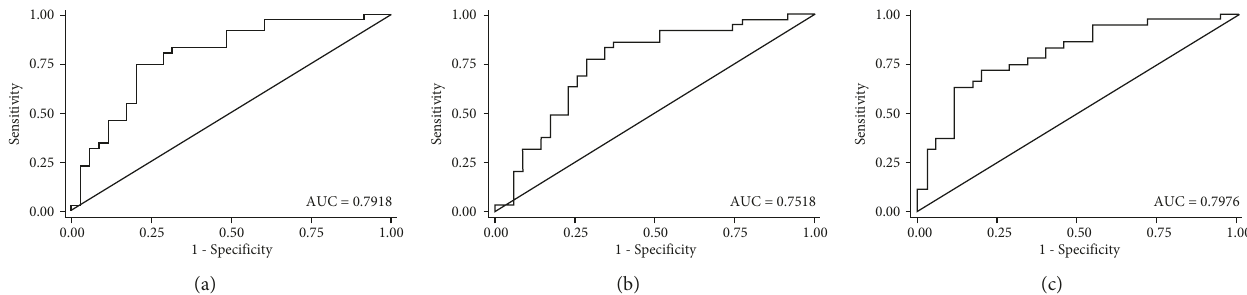
Figure 3: The receiving operating characteristics curve of combined ratio index of angle parameters in differential diagnose of ectopia lentis. ((a) TIAr250+TIAr500 (AUC � 0.792); (b) TIAr250+TIAr750 (AUC � 0.752); (c) TIAr500+TIAr750 (AUC �